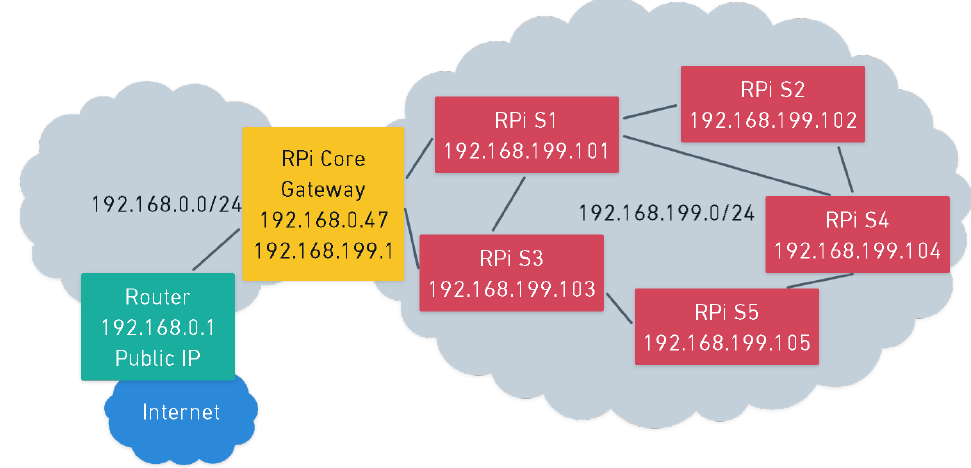
Figure 7. Example of a logical network design with five nodes (in red), one core (in yellow) and one router (in green).